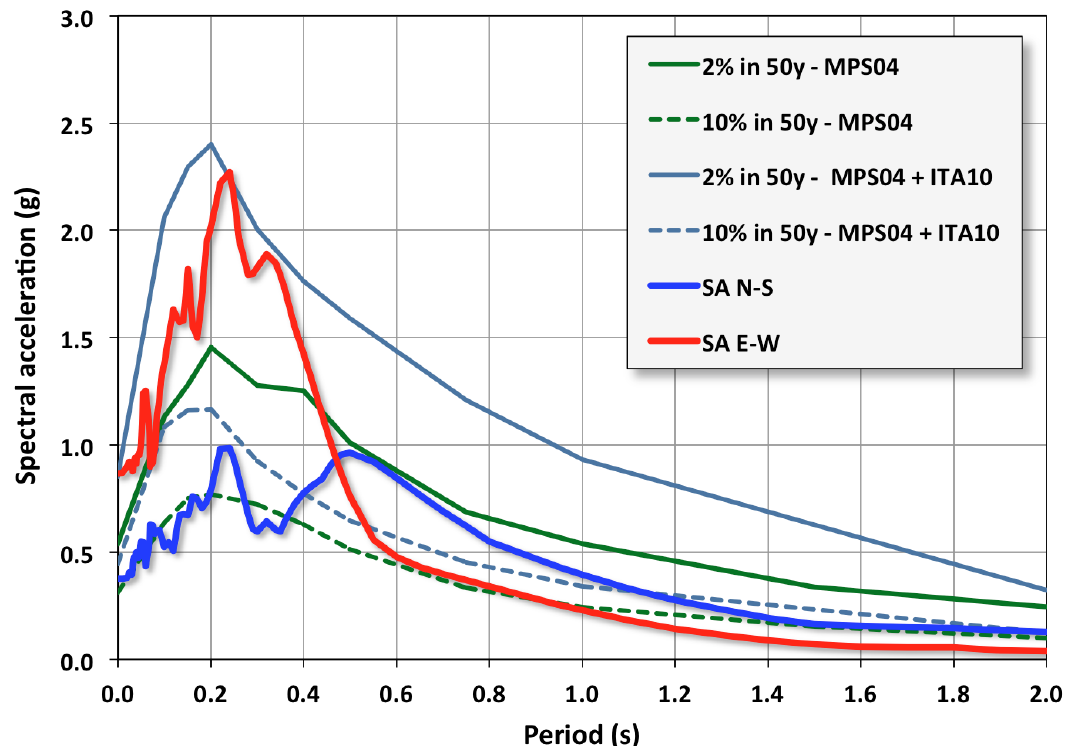
Figure 5. Comparison between the horizontal acceleration response spectra (5% damping, N-S and E-W components) of the 24 August Mw 6.0 mainshock recorded at AMT station and the UHS of MPS04 for soil class B and of MPS04 modified us- ing the ITA10 GMPE [Bindi et al., 2011] (for soil class B), at the node of the computational grid closest to AMT, for 2% and 10% probability of exceedance in 50